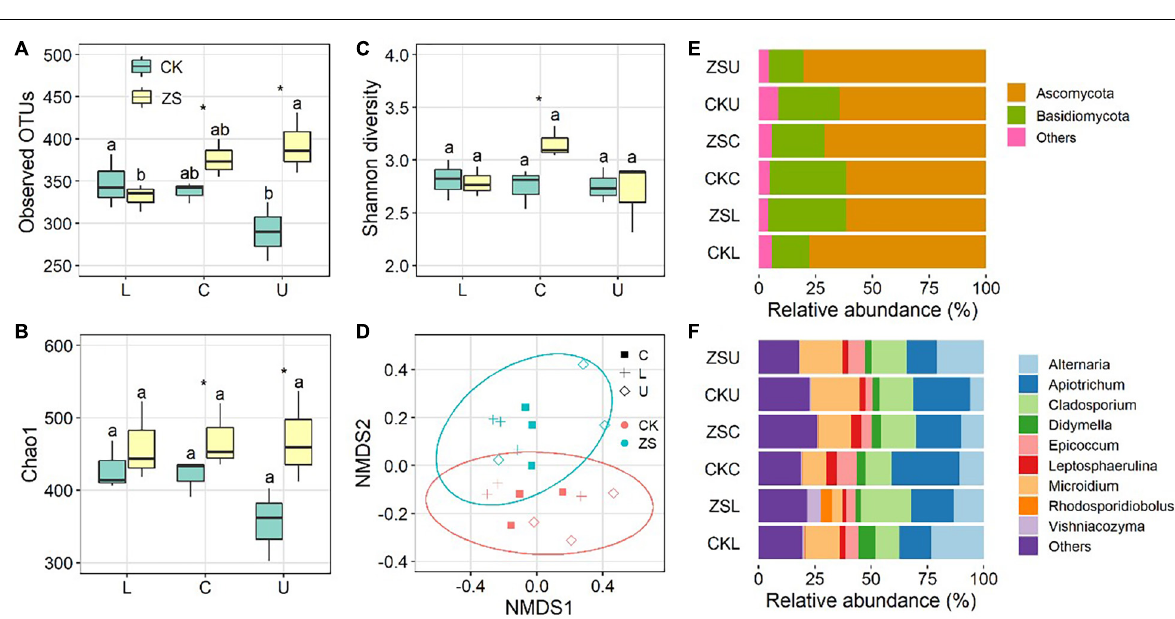
FIGURE 2 | Observed OTUs (A) , Chao1 index (B) , Shannon diversity (C) , Non-metric multidimensional scaling analysis, (D) and the relative abundance at phylum (E) and genus (F) level of endophytic fungal community in ordinary (CK) and nornicotine-enriched (ZS) tobacco leaves at lower (L), center (C), and upper (U) plant sections. Different letters above the boxes indicated significant differences among plant sections from the same tobacco types (CK or ZS), while the significant differences between CK and ZS at the same plant sections are marked by asterisks ( p <